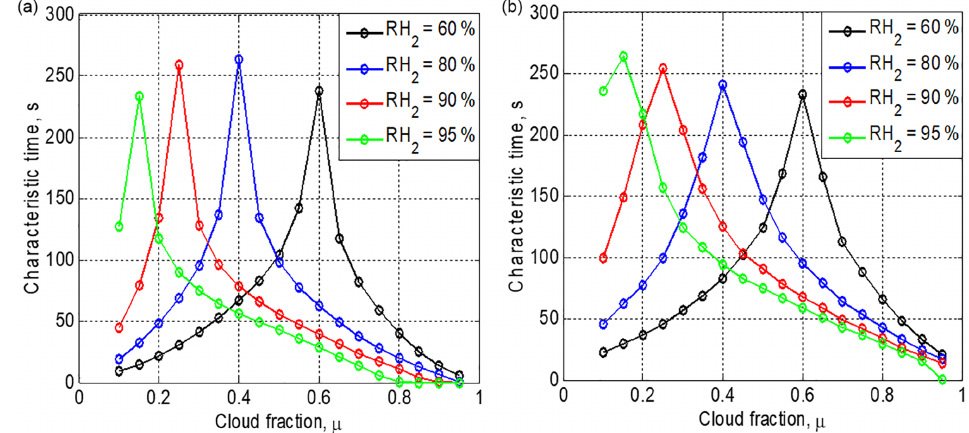
Figure 7. Time required to reach the equilibrium state vs. the cloud fraction at different initial RH for the initially narrow DSD (a) and the initially wide DSD (b) . Parameters of DSD are given in Table 1. The initial mixing parameters are T = 10 ◦ C, p = 828.8mb and L = 40m.